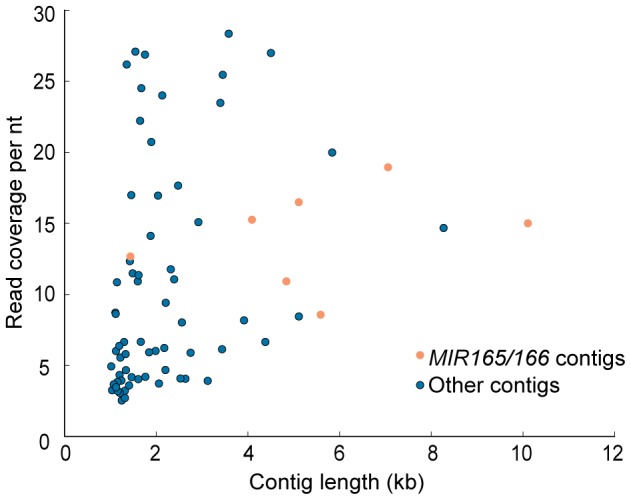

de novo assembly of enriched MIR166 and MIR165 loci.Coverage and length of contigs longer than one kb assembled by Velvet, using 1% of the paired-end data, are shown. Light brown dots: Contigs hosting a sequence targeted by the capture probe. Blue dots: Other contigs with no complementarity to the capture probe.